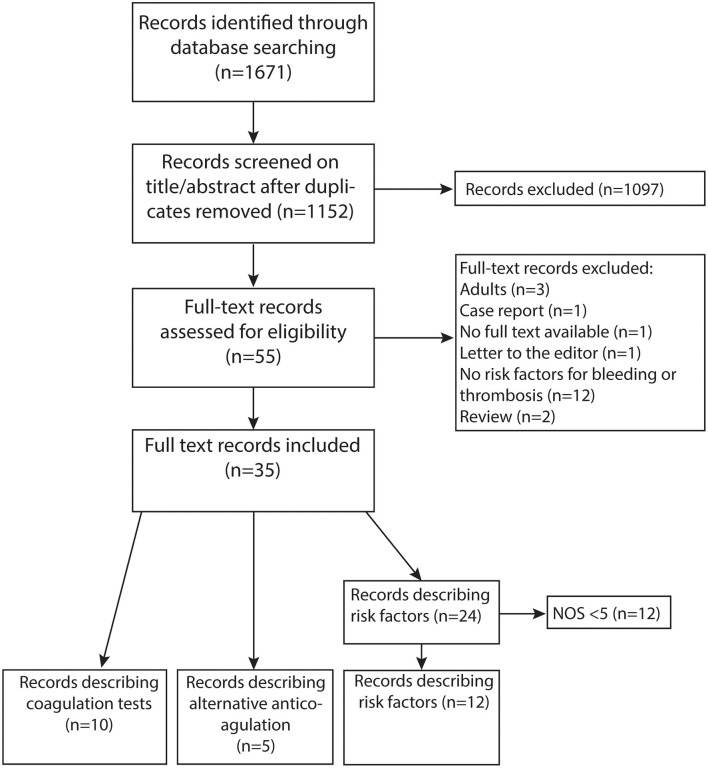
PRISMA flow diagram of literature search (11).